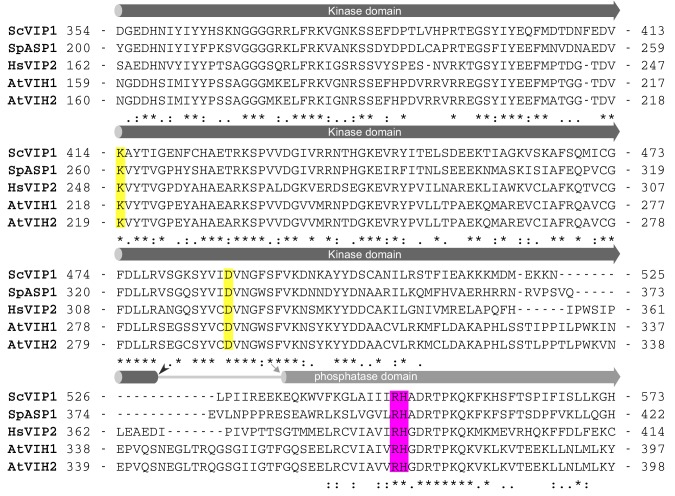
The kinase domain and phosphatase domain of VIHs/PPIP5Ks are conserved among different species.Structure-based sequence alignment of the kinase - phosphatase cores of Saccharomyces cerevisiae Vip1 (Uniprot (https://www.uniprot.org/) identifier: Q06685), Schizosaccharomyces pombe ASP1 (Uniprot identifier: O74429), Homo sapiens PPIP5K22 (Uniprot identifier: O43314), Arabidopsis thaliana VIH1 (Uniprot identifier: Q84WW3), and VIH2 (Uniprot identifier: F4J8C6). Predicted kinase domain and the N-termini of the phosphatase domains in VIHs/PPIP5Ks are shown as dark and light gray cylinders, respectively. Linker regions are indicated by gray lines. Conserved residues that were mutated in this study are highlighted in yellow for the kinase domain and in magenta for the phosphatase domain.